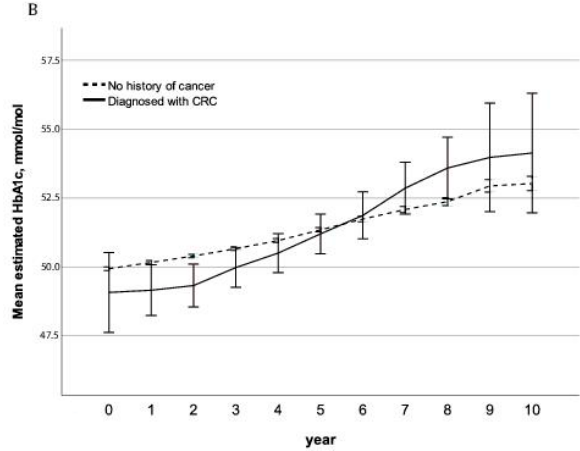
Figure 2. Estimated mean of the outcomes ( A ) Estimated mean probability at target HbA1c level during follow-up. ( B ) Estimated mean HbA1c (mmol/mol) during follow-up. Year 0 represents the cohort entry year, and year 10 represents the data for patients being followed for 10 years. Adjusted for baseline age, gender, diabetes duration, number of oral drugs, use of insulin and baseline year. The horizontal bars represent the 95% confidence intervals.